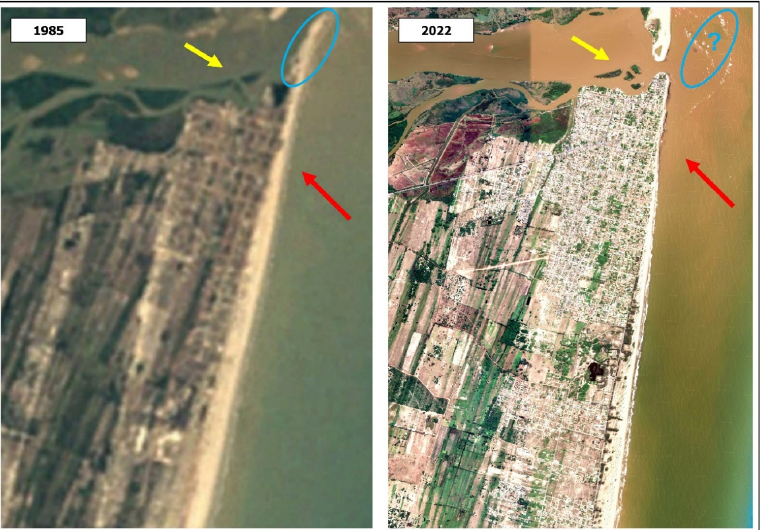
Figure 7. Comparison of the intense coastal erosion zone to the south of the river delta between 1985 and 2022 (after Google Earth Pro 2022). The red arrow is the significant narrowing of the sand strip on the coast near the mouth; the blue circle shows the presence of a sandy point that does not cur- rently exist, and the yellow arrow indicates small river islands and bars that were distant from the coast and are now exposed to wave action.